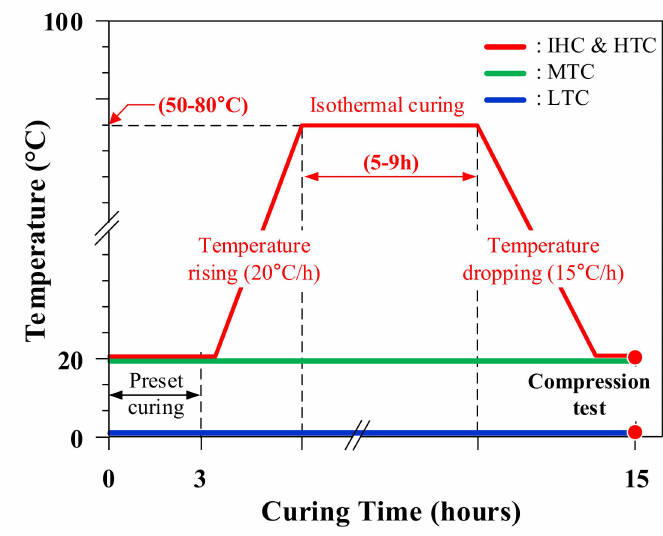
Figure 4. Heating